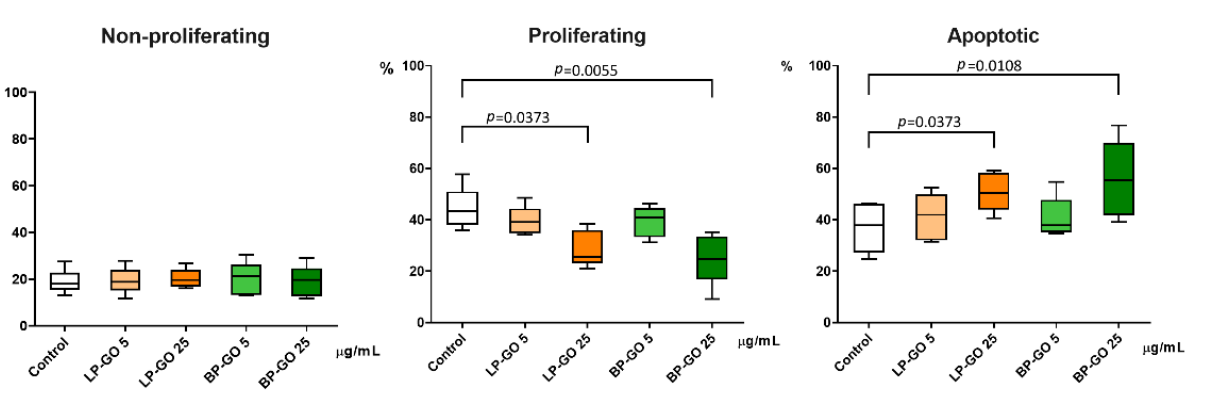
Figure 5. Percentages of non-proliferating, proliferating, and apoptotic cells in cultures of activated T-helpers with P-GO nanoparticles. Note: n = 5; the x -axis indicates the type and concentration of nanoparticles; the y -axis is the percentage of cells in corresponding gate from all cells. Control — culture without GO. Data are presented as median (Me) and quartiles (Q1 – Q3).